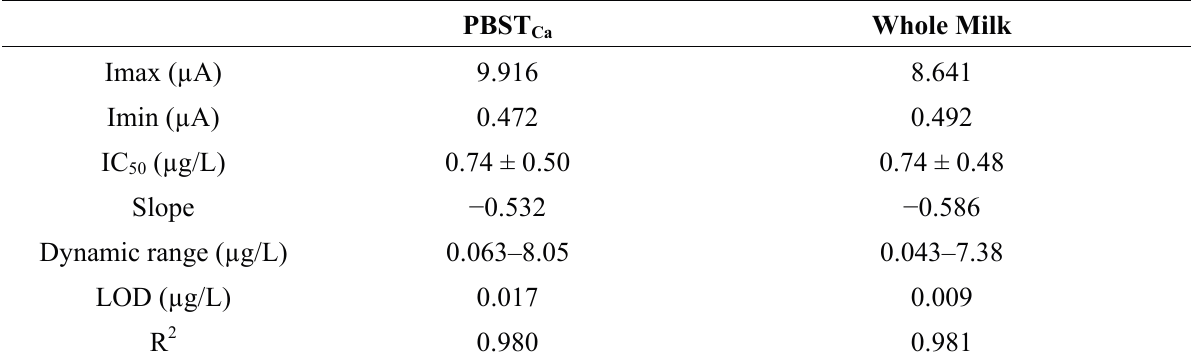
Table 4. Features of the amperometric magneto-immunosensor (AMIS) in PBST and whole milk samples using ciprofloxacin as